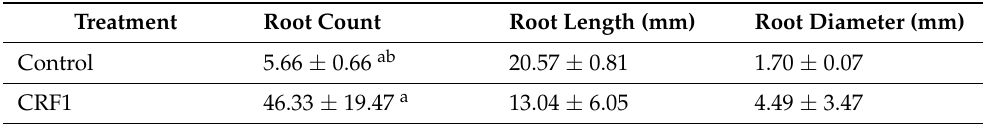
Table 4. Root growth parameters measured in March 2020 at a depth of 15.7–31.4 cm. A one-way analysis of variance (ANOVA) with a Tukey honestly significant difference (HSD) test was used to determine significant differences between means. Letters indicate statistically significant differences ( p ≤ 0.05). Data represents means ± standard